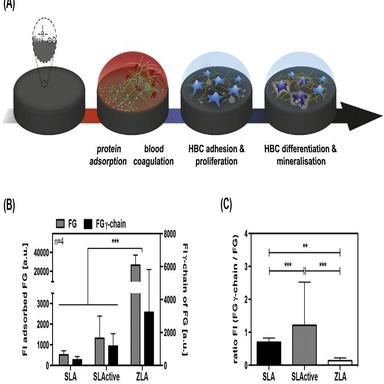
(A) Schematic illustration of the advanced in vitro model including a blood incubation step prior HBC culture on top of the material's surface. (B) Fibrinogen (FG) adsorption as a function of the dental implant material and surface modification. Fibrinogen adsorption and antibody-accessibility of the fibrinogen C-terminal region of the --chain were analyzed via immunohistochemistry and obtained fluorescence intensities (FI) measured with a microarray scanner. (C) Based on measured FI values, the ratio of -